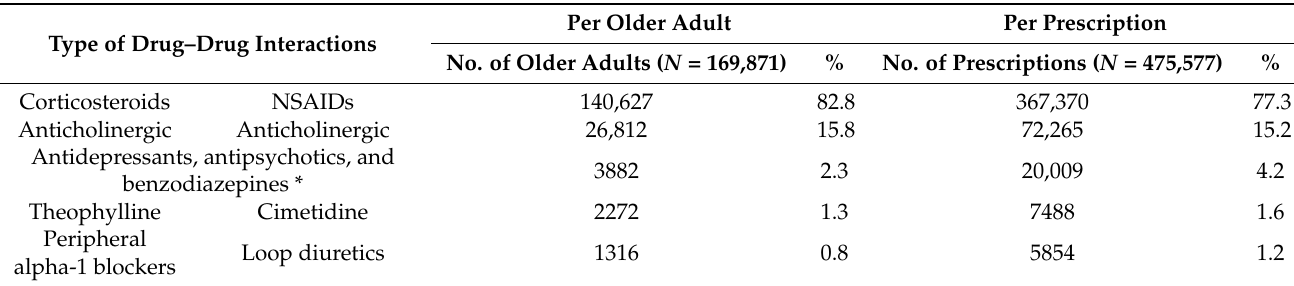
Table 3. Top 5 prescribed drug–drug interactions.